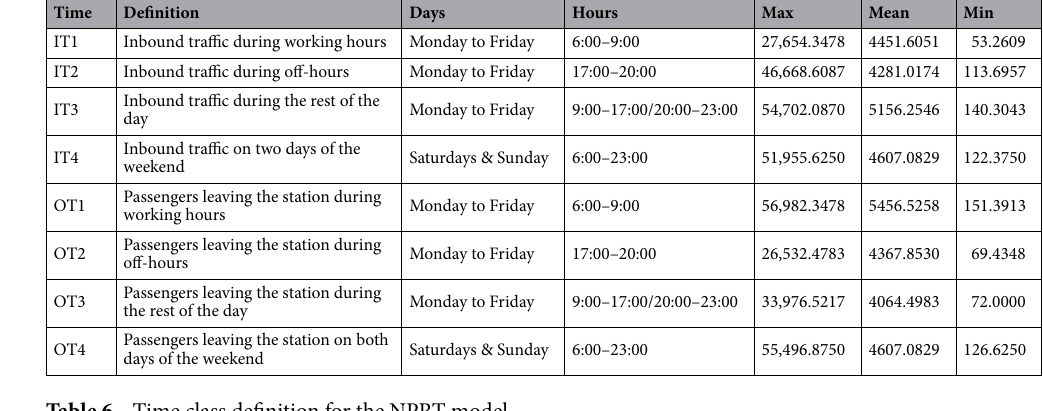
Table 6. Time class definition for the NPRT model.